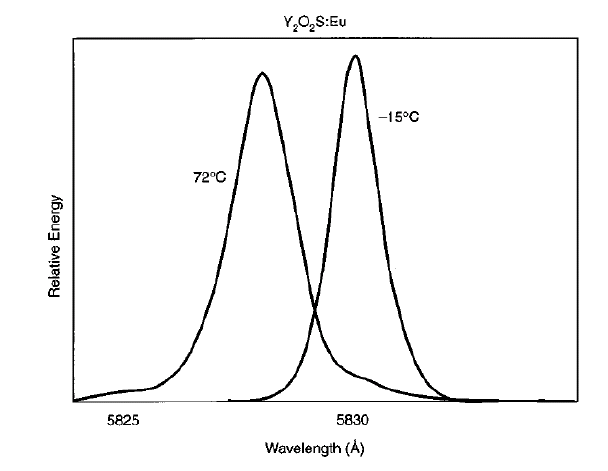
Figure 19. Emmsion lineshift and linewidth variation with temperature